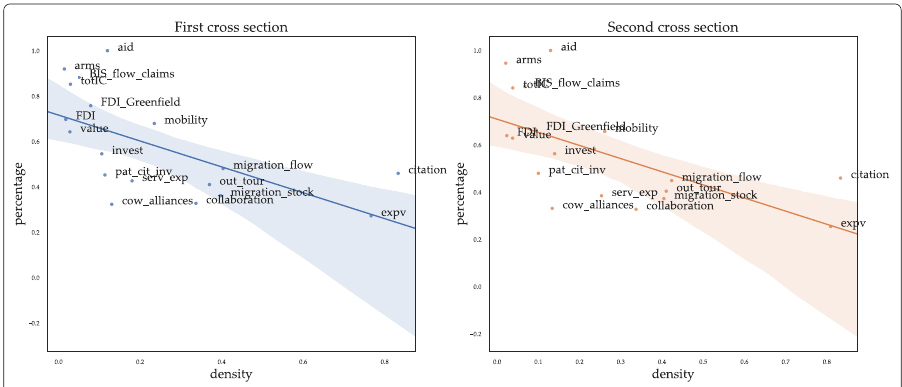
Fig. 16 Relation between percentage of values preserved by filter and density before filtering